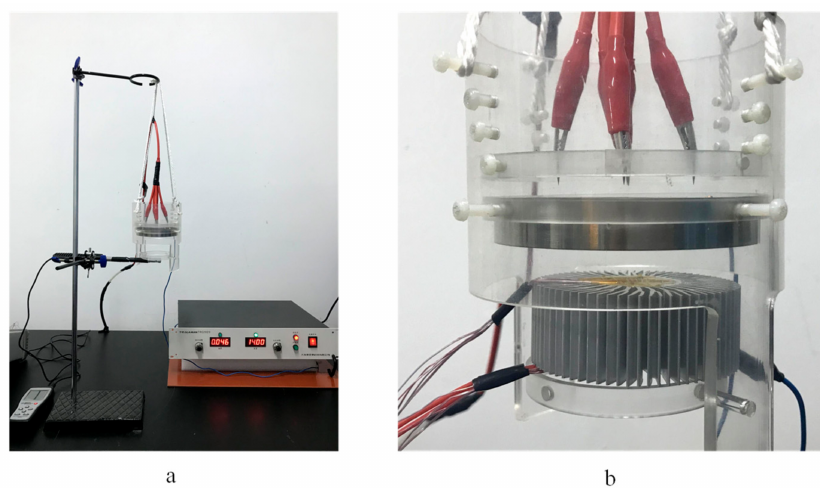
Figure 6. Photographs of the experimental device: ( a ) ionic wind velocity measurement; and ( b ) temperature measurement of the heating film in the LED cooling device.